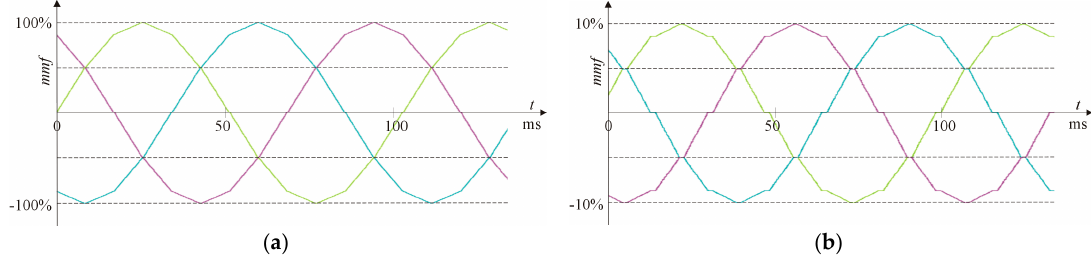
Figure 10. Mmf s in the stator of the PMSG when its output power is equal to a nominal value ( a ) and